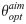
Apparatus and Experiment 1 design.A) Participants held the handle of a robotic arm. A semi-silvered mirror reflected images (target and home position) from an LCD screen onto a horizontal plane aligned with the shoulder, and occluded vision of the hand and arm. Participants made forward reaches from a home position, attempted to pass through a virtual target, and stopped once they passed over a horizontal line that disappeared when crossed. We informed participants that they would receive positive reinforcement for each target hit (target expanded, pleasant noise, and monetary reward). Unbeknownst to them, we manipulated B) the reinforcement landscape (steep or shallow), which dictated the probability of receiving reward (y-axis) as a function of their reach angle (x-axis). Reach angle was calculated relative to the line that intersected the target and home position, where the latter was the centre of rotation. To control for individual differences in movement variability, these reinforcement landscapes were scaled according to baseline reach behaviour. Accordingly, a z-score of 0.0 corresponds to their average baseline reach angle. A z-score of 1.0 corresponds to a reach angle that was 1.0 standard deviation, relative to baseline movement variability, away from the average baseline reach angle. We expected participants to adjust their aim such that they moved from their average baseline reach angle (0.0 z-score) to one that produced greater reward (z-score between 3-6). Critically, we predicted that participants experiencing the steep (blue) reinforcement landscape would learn to adjust their reach aim at faster rate than those experiencing the shallow (orange) reinforcement landscape (Experiment 1). C) Using Eqs 7–9, we accounted for movement variability to calculate the probability of reward (y-axis) given intended reach aim (x-axis). The blue and orange vertical dashed lines correspond to the optimal intended reach aim (θoptaim, Eq 10) that maximized the probability of reward for the steep and shallow reinforcement landscapes, respectively.